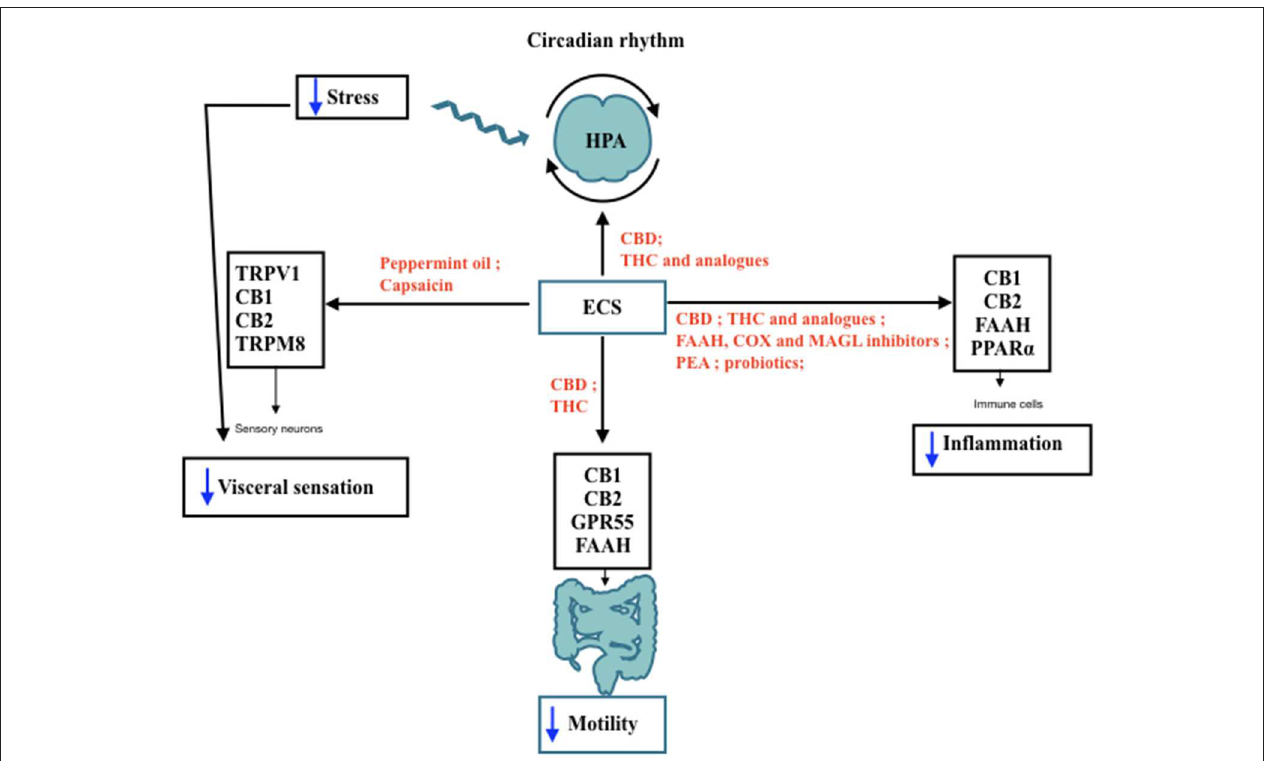
FIGURE 1 | IBS features modulated by ECS. Schematic representation of the Endocannabinoid System (ECS) involvement in lBS features and its interaction with hypothalamic-pituitary-adrenal (HPA) axis throughout day/night. The black arrows indicate the receptors and the target sites controlled by ECS components. In red are shown the agents capable of modulating ECS activities that may be useful to improve IBS symptoms, such as motility, visceral pain, and low-grade inflammation. Blue arrows indicate a decrease in the functions targeted by ECS stimulation. TRPV I, Transient receptor potential vanilloid I; CB I, Cannabinoid Receptor I; CB2: Cannabinoid Receptor 2; TRPM8, Transient receptor potential melastatin 8; CBD, cannabidiol; THC, tetrahydrocannabinol; FAAH, fatty acid amide hydrolase; COX, cyclooxigenase; MAGL, monoacyl glycerol lipase; PEA, palmitoylethanolamide; PPARa: Peroxisome proliferator-activated receptor